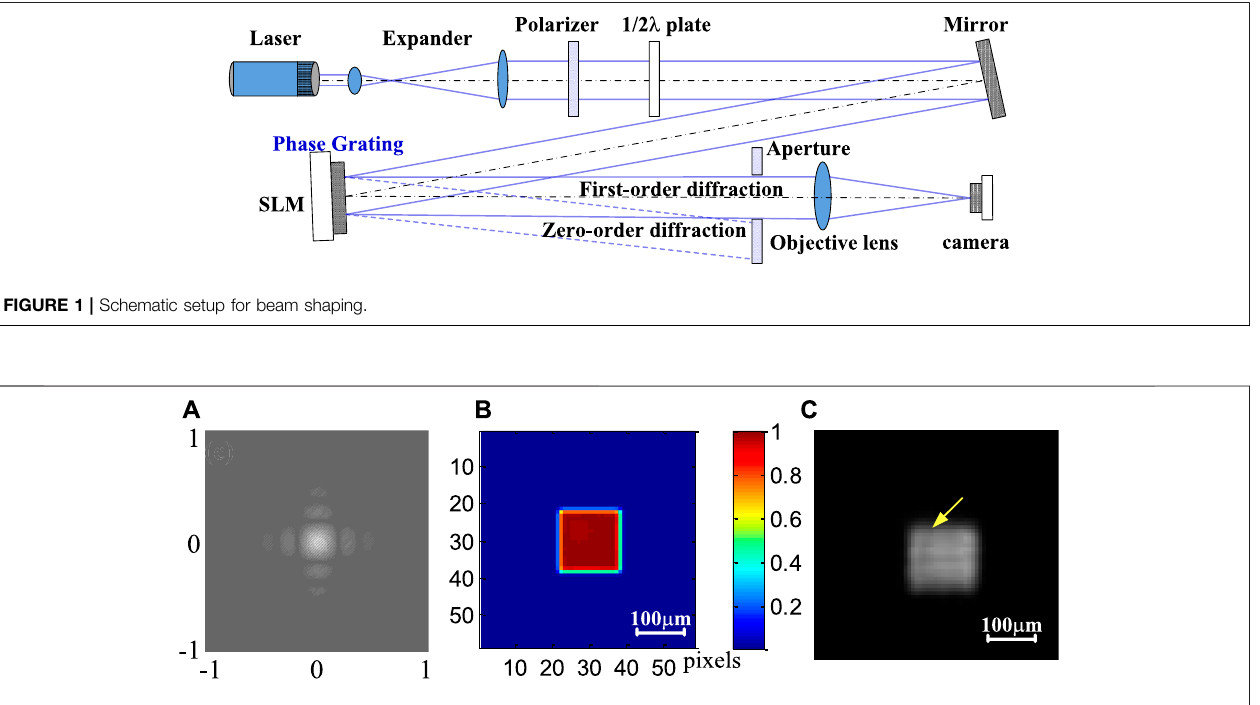
FIGURE 2 | Ideal and experimental results of square fl attop focusing beam shaping with complex modulation algorithm. (A) Phase mask, (B) ideal result of focal facula, and (C) the experimental result of focal facula.